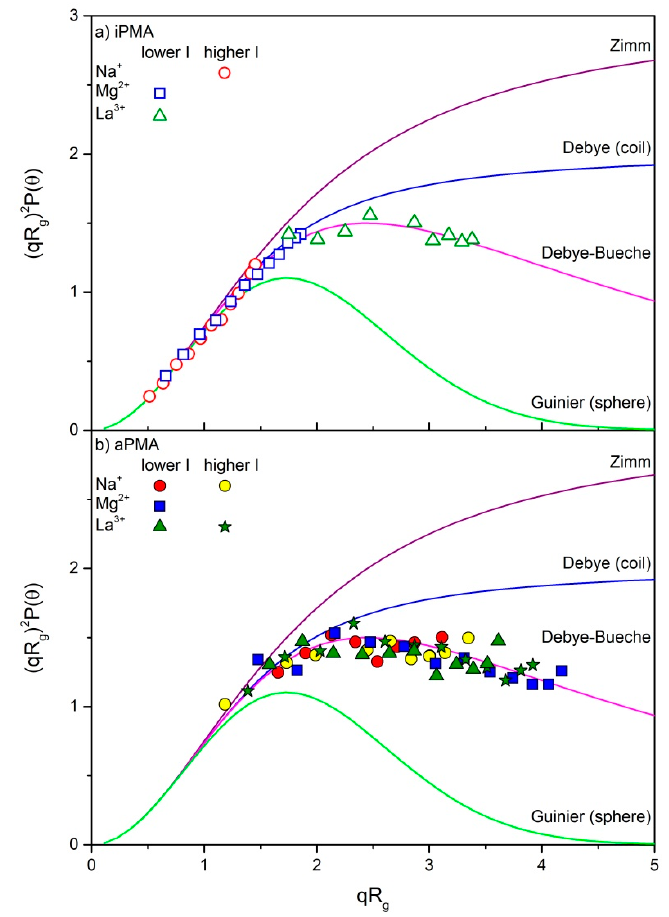
Figure 3. Kratky plot (the dependence of ( qR g ) 2 P ( θ ) on qR g ) for four selected topologies (solid lines; for details on these scattering functions see [49]) and the experimental data for associates of ( a ) iPMA (different α N , see Table 1) and ( b ) aPMA ( α N = 0) in aqueous solutions of NaCl, MgCl 2 and LaCl 3 (for values of I see Table 1): c m = 2 g · L − 1 .